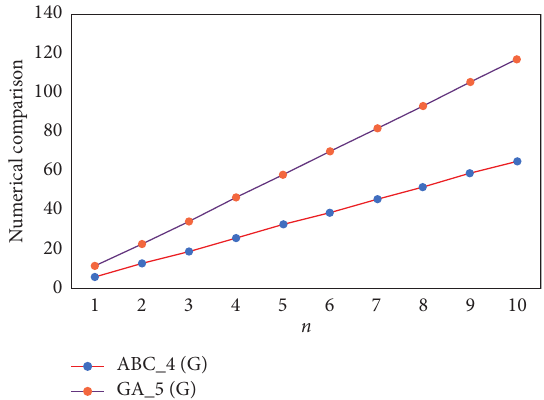
Figure 4: Comparison of ABC